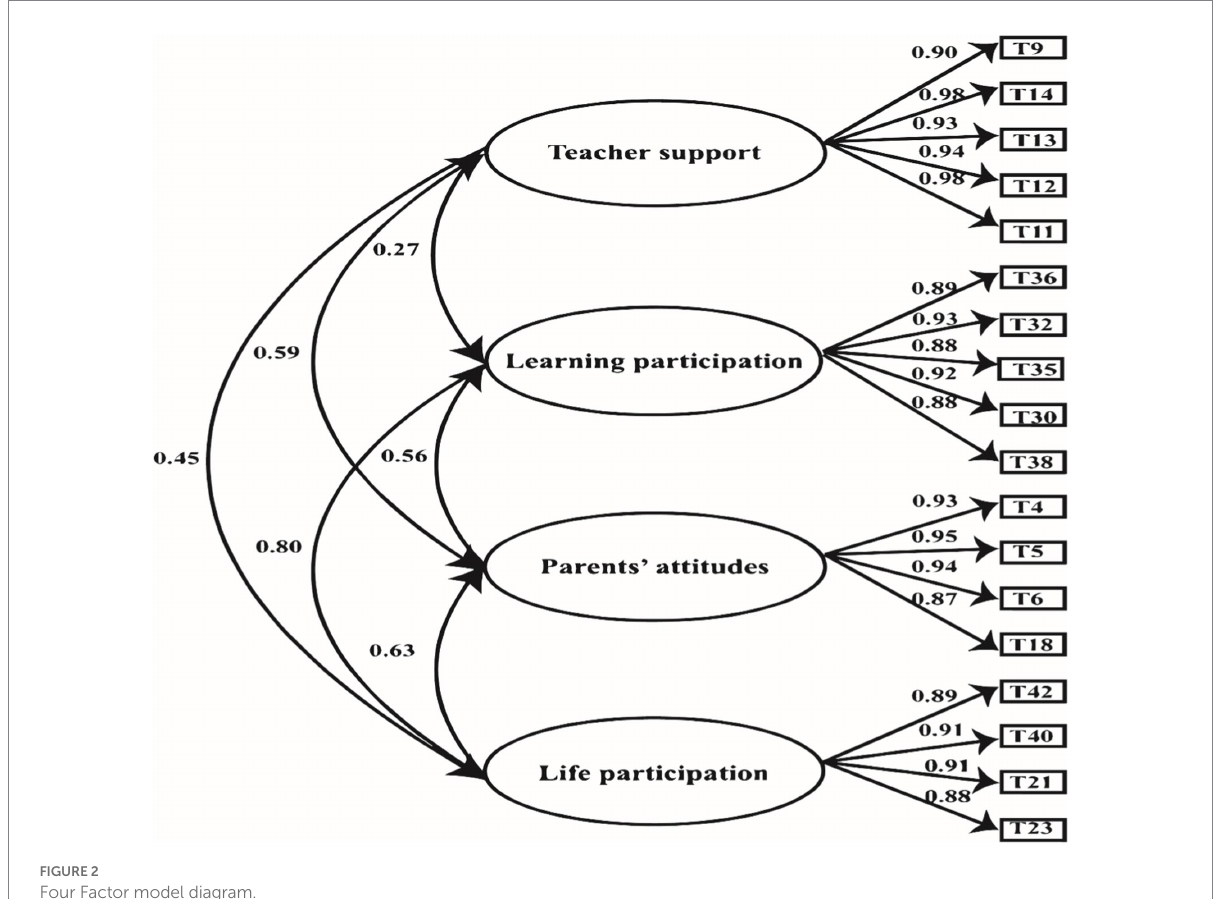
FIGURE 2 Four Factor model